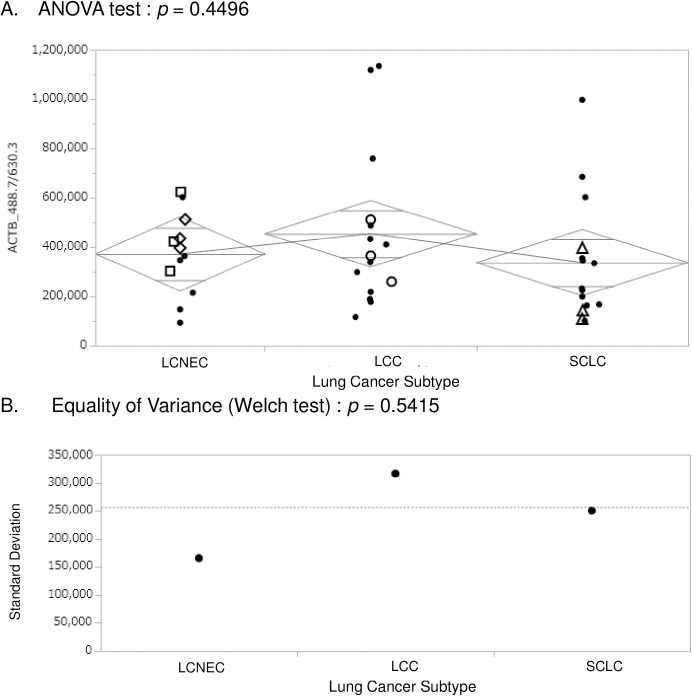
Statistical evaluation for the 42 SRM AUC raw data obtained for the SRM transition of ACTB_488.7/630.3 [doubly-charged β-actin peptide AGFAGDDAPR (m/z 488.7) to the singly-charged y6 fragment (m/z 630.3)] measured in triplicate across all the 14 clinical samples.The raw SRM AUCs obtained by triplicate LC/SRM-MS runs for some of samples are also indicated (□: LCNEC, Patient No. 1; ◇: LCNEC, Patient No. 4; ○: LCC, Patient No. 13; △: SCLC, Patient No. 24).